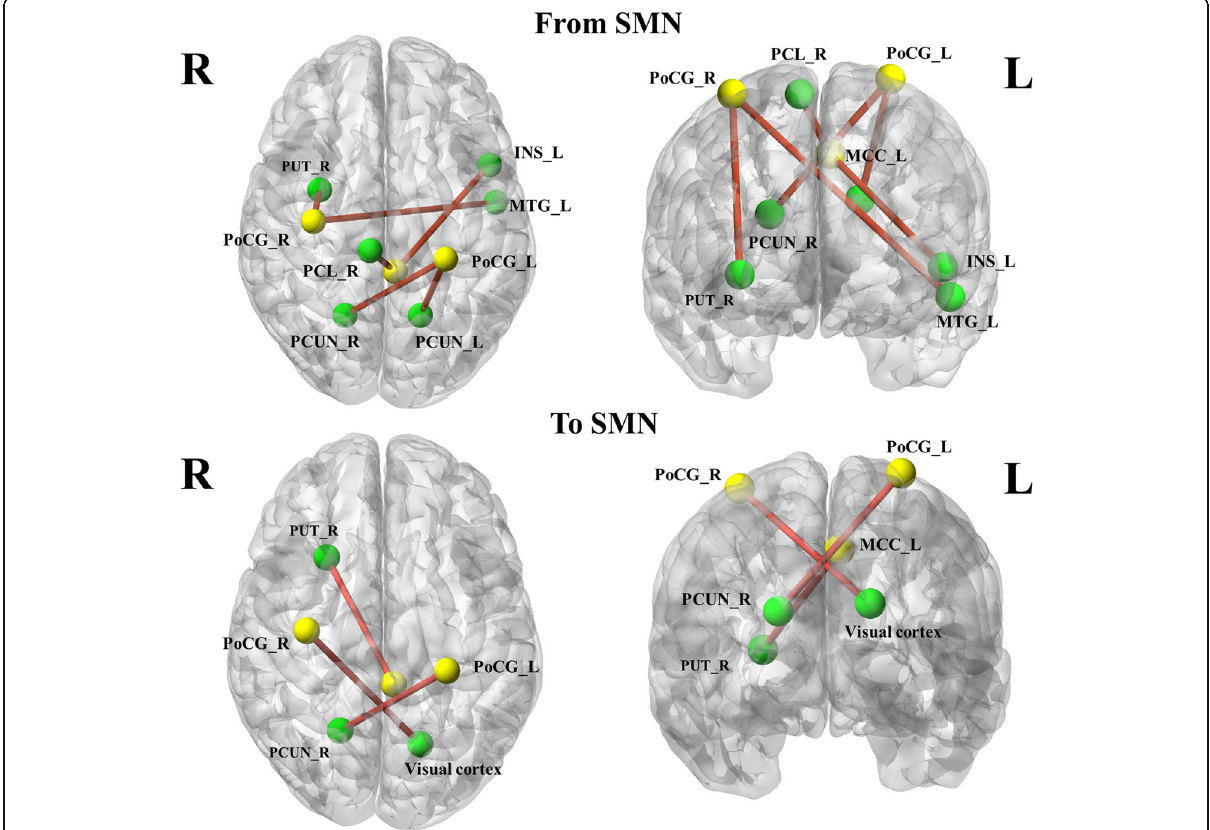
Fig. 2 Altered effective connectivity from the SMN to other regions (First row) and from the other brain regions to SMN (Second row) in migraineurs without aura compared with healthy controls. Thresholds were set at a p < 0.001 (uncorrected). INS: insula; MCC: midcingulate cortex; MTG: middle temporal gyrus; PCL: paracentral lobule; PCUN: precuneus; PoCG: postcentral gyrus; PUT: putamen; SMN: sensorimotor network; L: left; R: